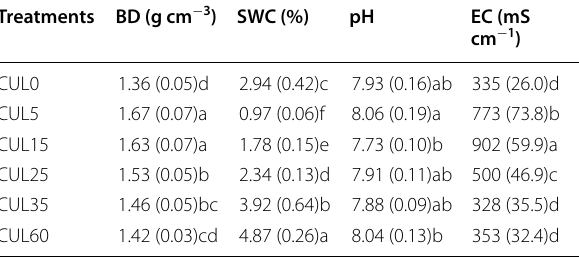
BD represents bulk density, SWC represents soil water content and EC represents electrical conductivity. Values represent means of six replicates, with standard errors shown in parentheses. Different lowercase letters indicate significant differences at p <